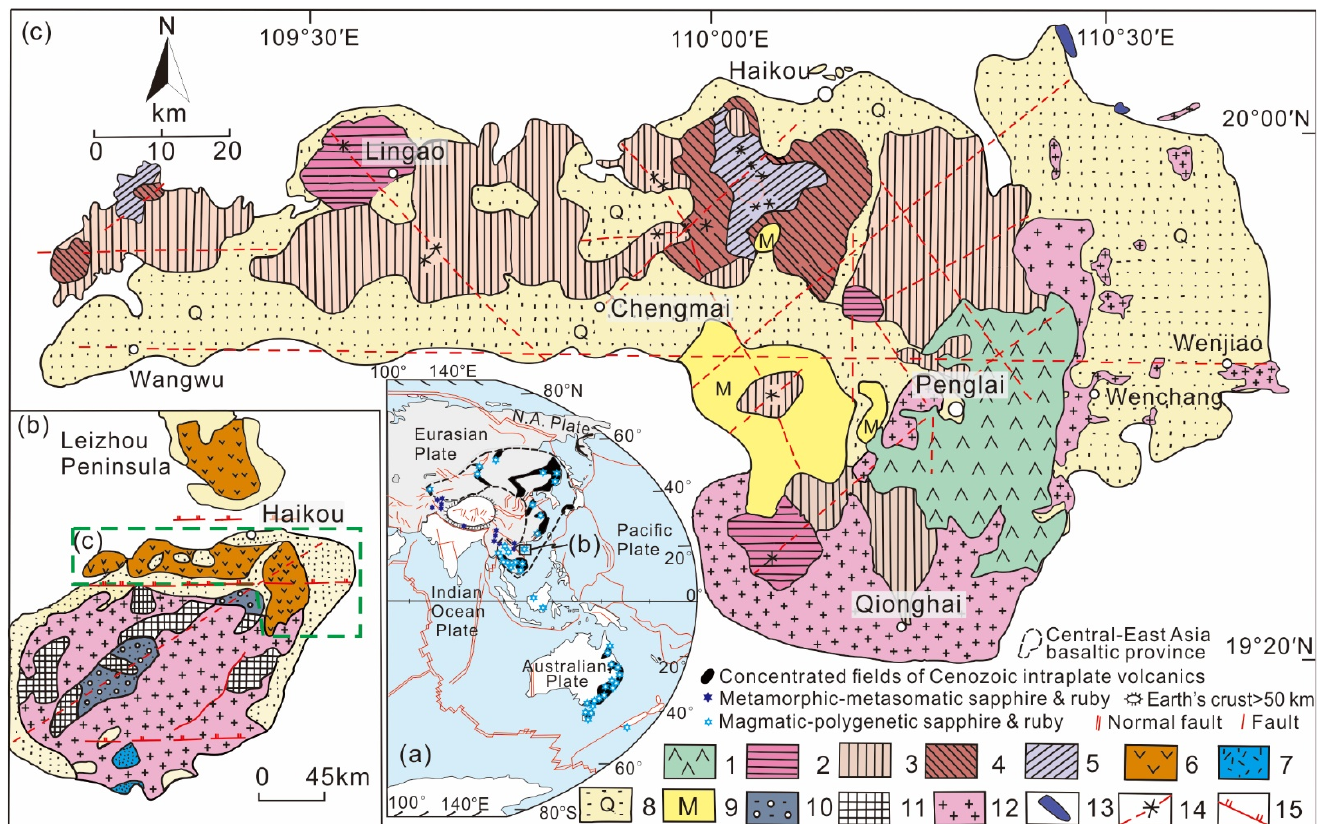
Figure 1. ( a ) The gem corundum occurrences and associated basaltic fields in Central and East Asia showing the location of the Hainan Island, modified from [19]; ( b ) simplified geological map of the Hainan Island separated from mainland China by the Qiongzhou Strait and ( c ) the distribution of late Cenozoic basaltic volcanism in the northern part of the Hainan Island, modified from [16,18]: 1—Shimengou/Shimacun Formation (Pliocene—Miocene); 2—Duowen Formation (middle Pleistocene); 3—Dongying Formation (middle Pleistocene); 4—Daotang Formation (late Pleistocene) ; 5—Shishan Formation (Holocene); 6—Cenozoic basalt; 7—intermediate acid extrusive rocks; 8—Quaternary sediments; 9—Mesozoic rocks; 10—Pre ‐ Cenozoic basalt; 11—Paleozoic rocks; 12—Mesozoic granite; 13—eclogite; 14—volcanoes and inferred faults; 15—nearly west–east striking regional faults; N.A. Plate—North American Plate.